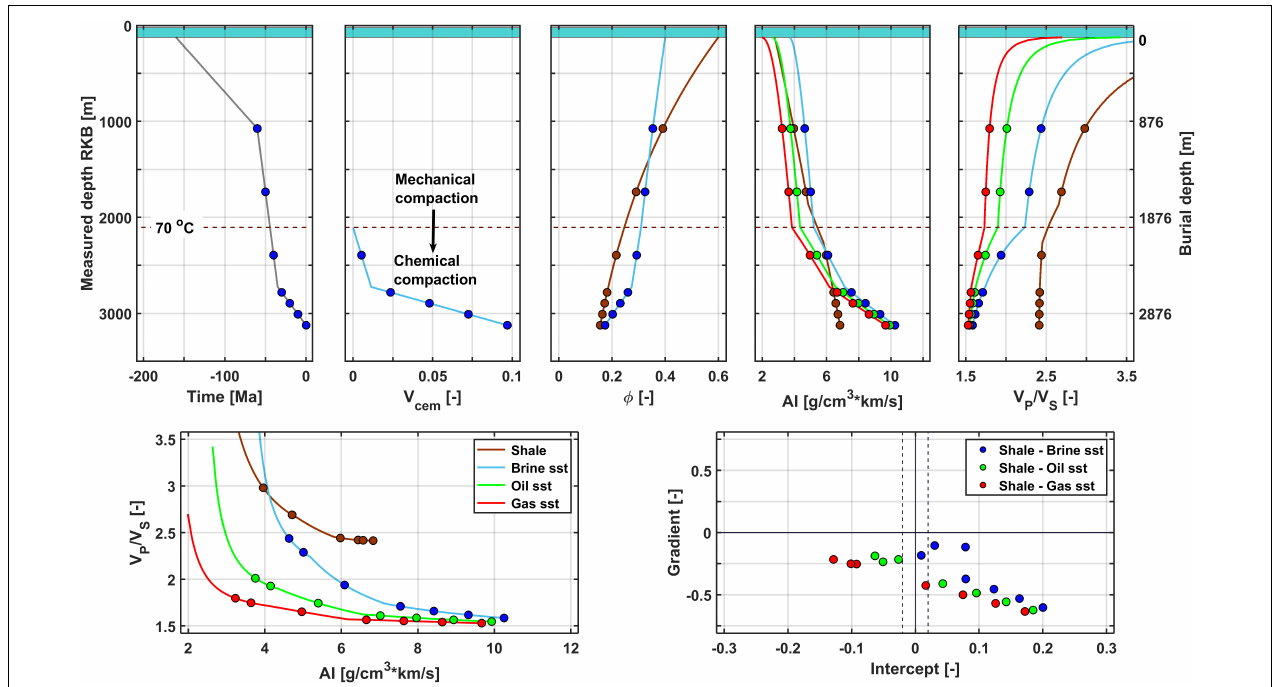
FIGURE 3 | Combined burial and rock physics modeling for a Jurassic sandstone with continuous subsidence. Note the drastic change in rock-physics, and seismic properties as the burial goes from mechanical to chemical compaction domain ( > ca. 70 ◦ C).